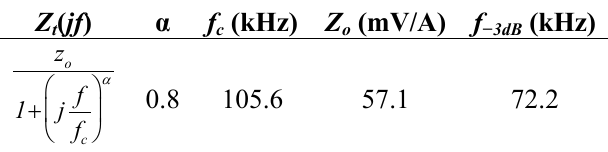
Table 1. GMR sensor ac large-signal fractional modeling parameters.